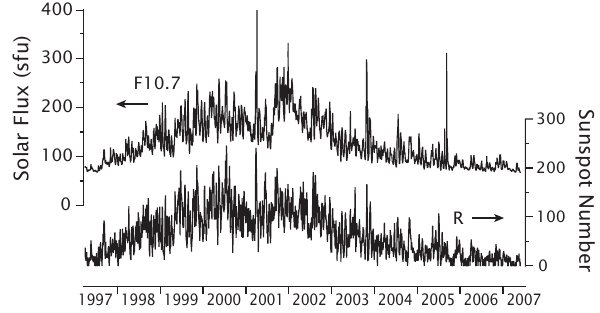
Fig. 2. Observed daily solar flux (upper trace with left scale) and daily sunspot number (lower trace with right scale) from April 1997 to June